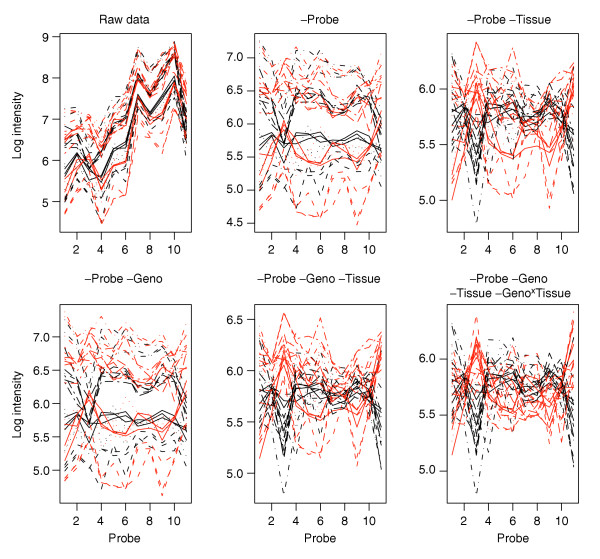
Normalization of hybridization intensity profile of 25mer probes in a probe set. The y axis is background-corrected normalized log intensity and the x-axis shows the positions of the 11 features along the unigene. Black lines trace the Golden Promise arrays, while red trace the Morex arrays. Different line types differentiate tissues. Each panel illustrates normalization for one of the major sources of variation: probe effect; probe and tissue; probe and genotype; probe, genotype and tissue; probe, genotype, tissue and genotype by tissue. 100 such plots are available from [35].